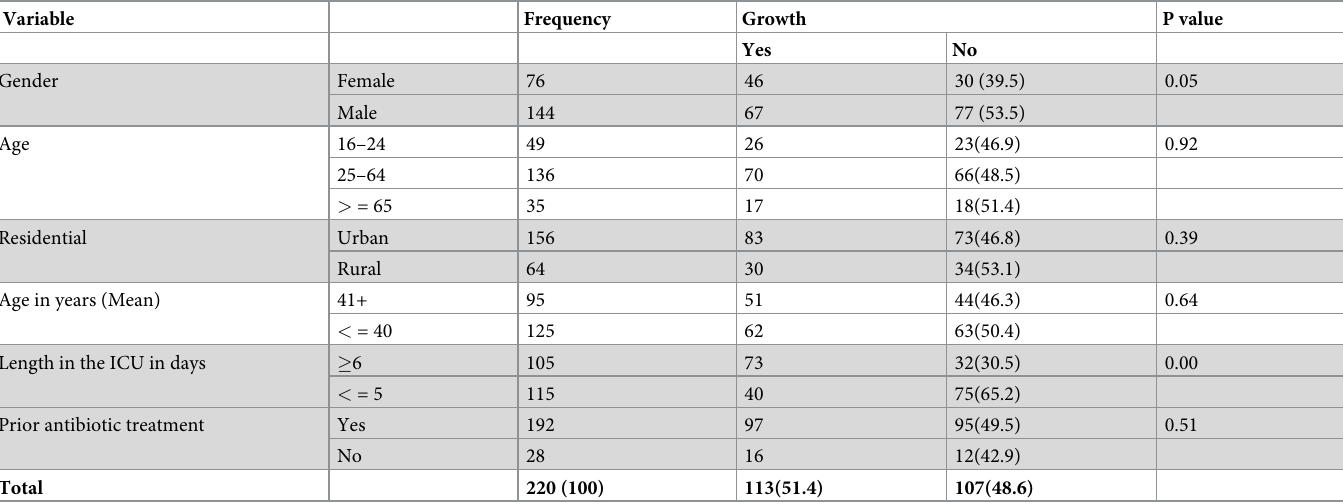
Table 3. Association bacteriuria/candiduria with possible risk factors.